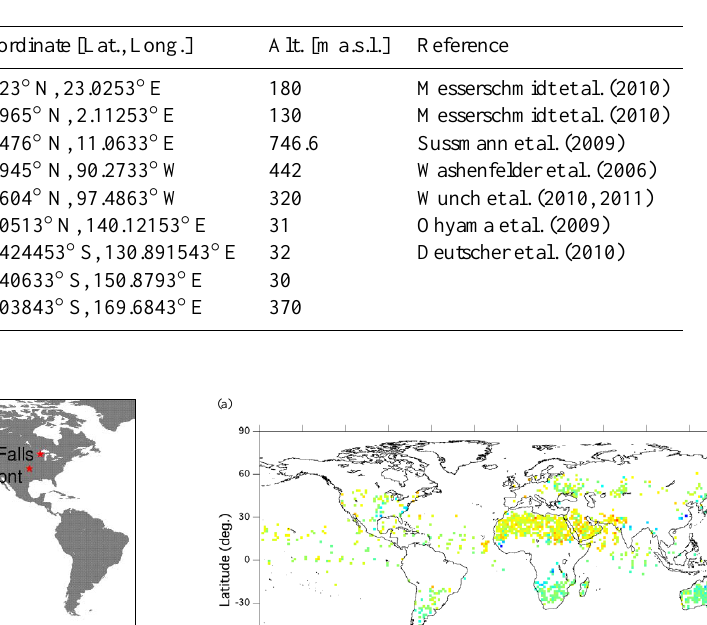
Table 1. Ground-based FTS sites used for GOSAT product validation.